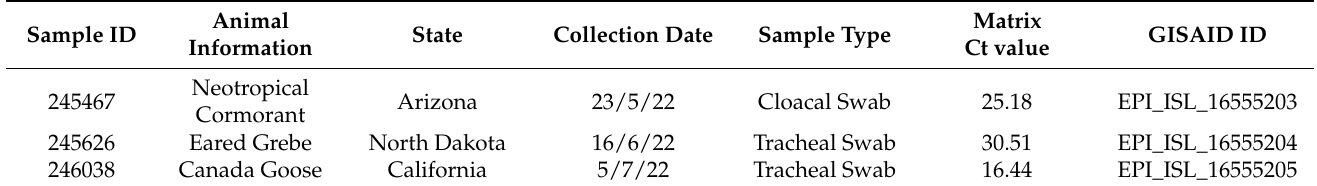
Table 1. Highly pathogenic H5N1 avian influenza virus-containing samples used in this